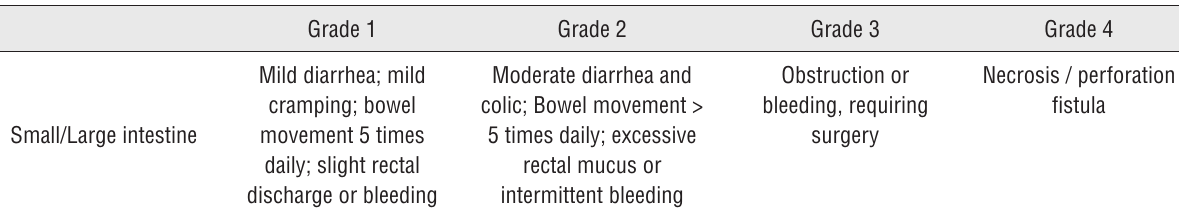
Figure 6 - RTOG score, used to evaluate late rectal toxicity (> 3 months). In St Lucas, only 2.8% of the patients had rectal toxicity, none higher than grade 2.